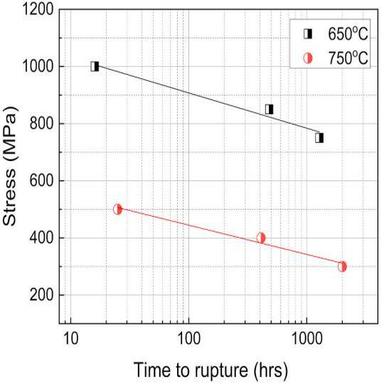
Stress rupture properties at different test temperature and stress levels.